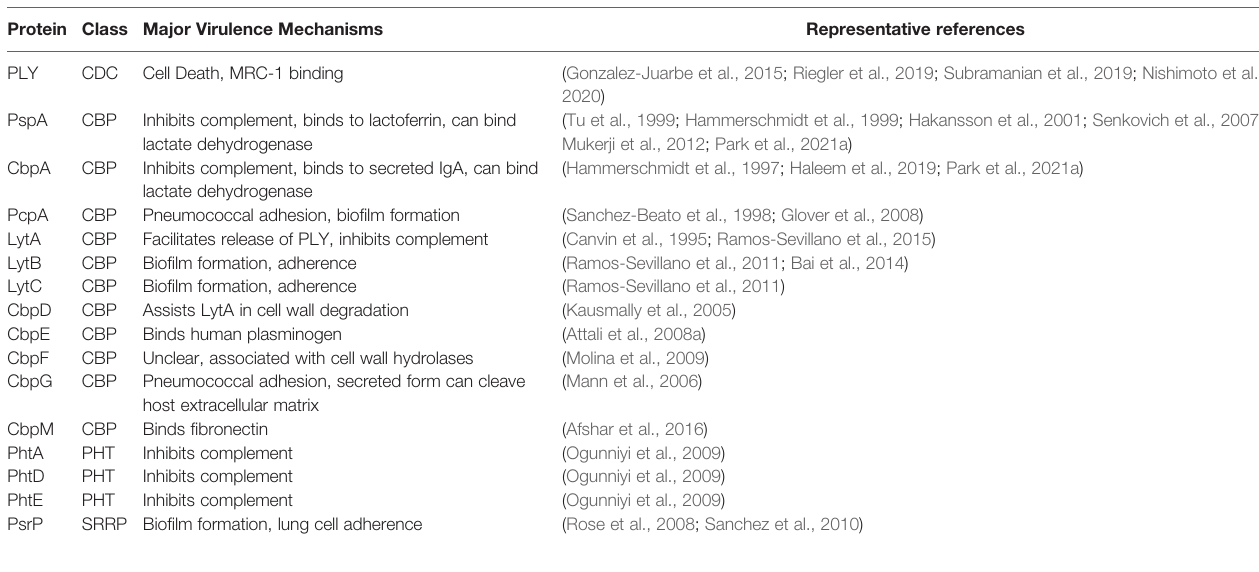
TABLE 1 | Major Spn surface protein